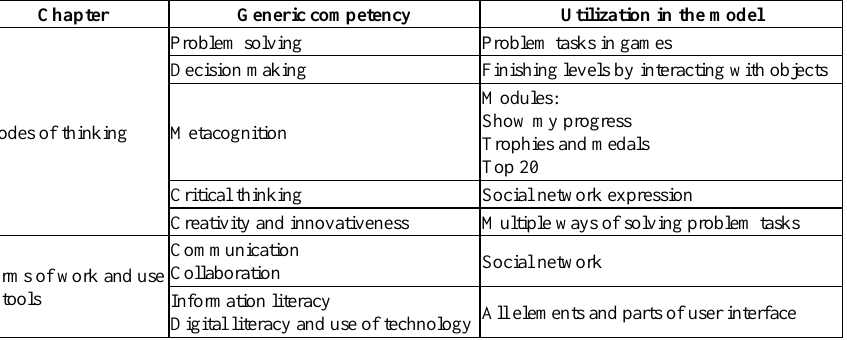
Table 2. Relationships between generic competencies and their utilization in the model Chapter Generic competency Utilization in the model